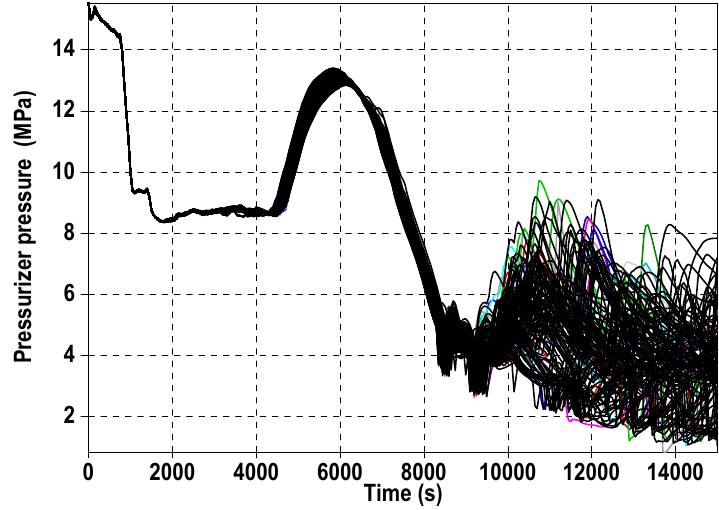
Figure 2. Pressurizer pressure.